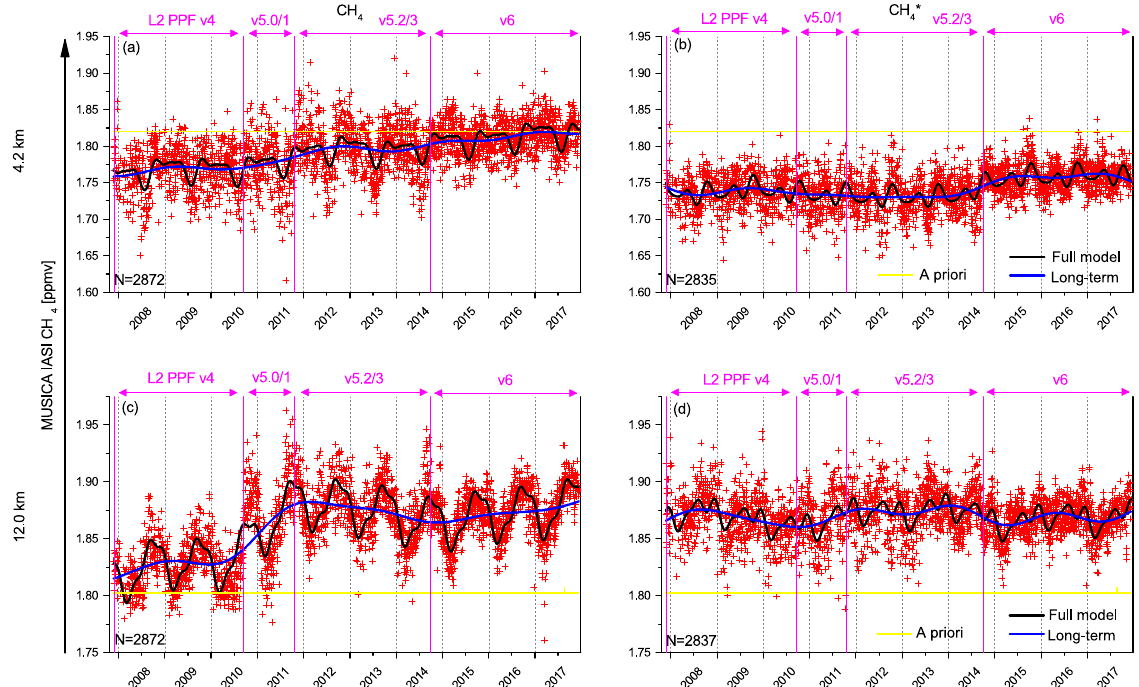
Figure C1. Example of continuous time series of MUSICA IASI daily mean data (red crosses) retrieved in the surroundings of Tenerife Island between 2007 and 2017: (a) and (b) for 4.2km altitude; (c) and (d) for 12km altitude; (a) and (c) for CH 4 ; and (b) and (d) for CH ∗ The yellow line is the a priori data used. The results of the multi-regression fit of the time series model are depicted as the black line and the time series model components describing the long-term behaviour are represented by the blue line. The periods with different EUMETSAT L2 PPF software versions that can affect the MUSICA IASI products are indicated by magenta